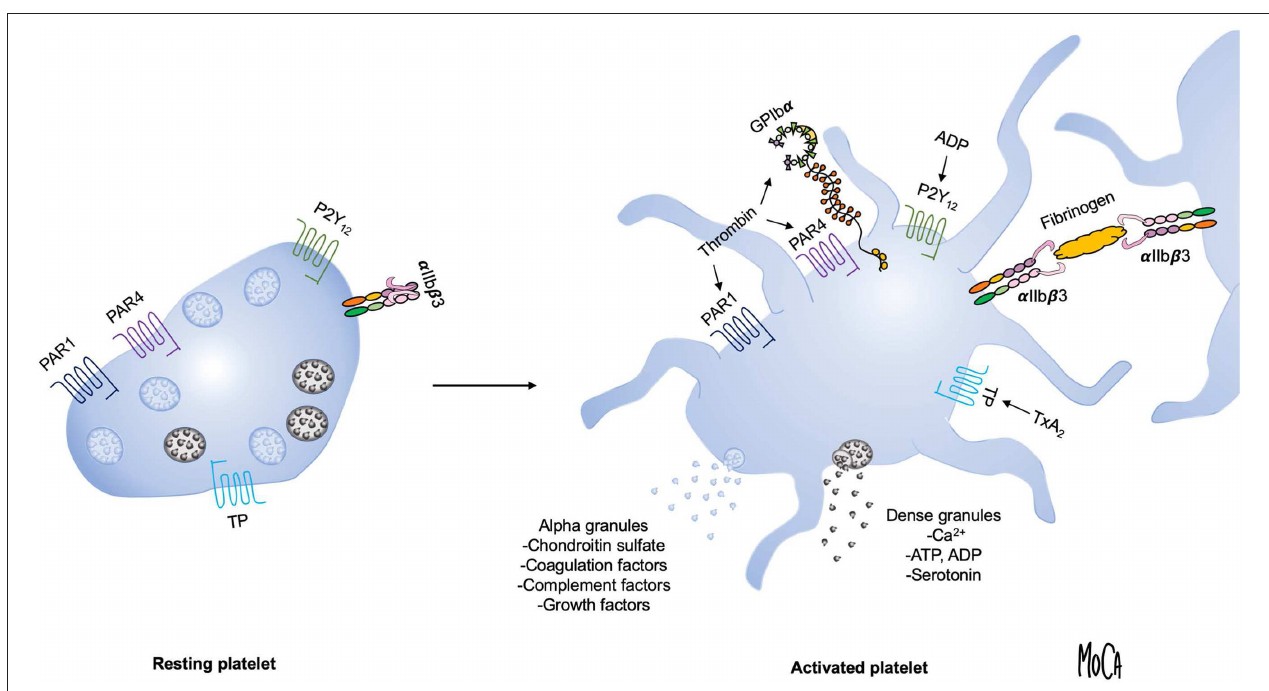
FIGURE 1 | Overview of platelet activation. Platelet activation triggers platelet shape change and granule exocytosis. Alpha granules (blue) contain growth factors, coagulation and complement components and chondroitin sulfate; release of dense granules (gray) provides a source of ADP, ATP, Ca 2 + , and serotonin. Selected platelet agonists and their receptors are indicated. Thrombin binds to GPIb α and activates protease-activated receptor 1 and 4 (PAR1 and PAR4, respectively), ADP activates the P2Y12 receptor, and thromboxane A2 activates the thromboxane (TP) receptor. Agonist stimulation results in integrin α IIb β 3 activation and the transition to an active conformation that binds fibrinogen and mediates platelet